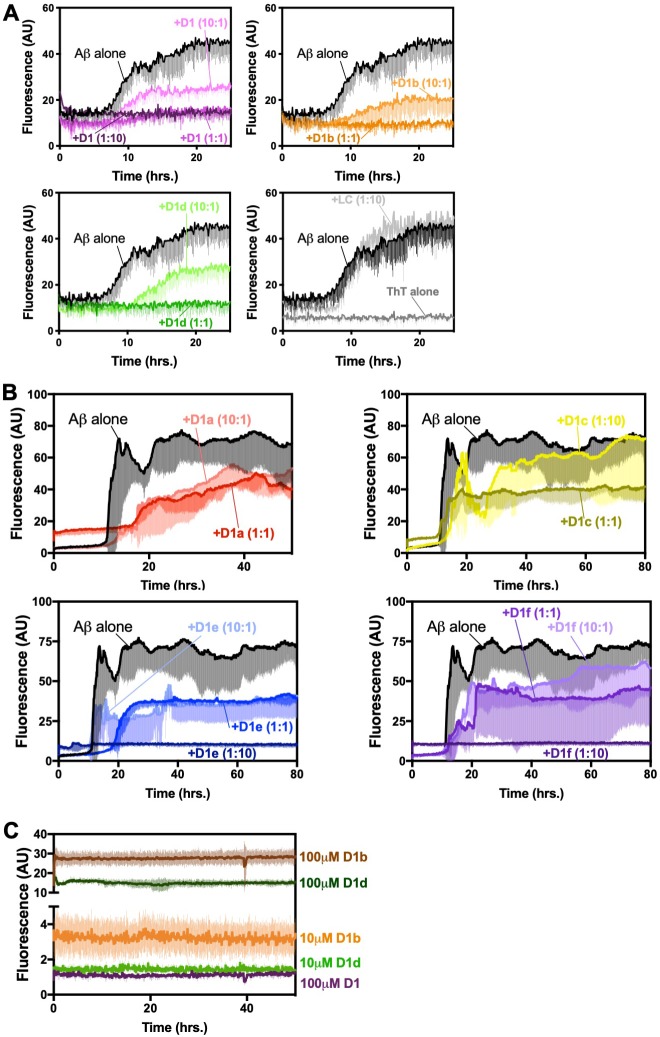
A Peptide inhibitors D1, D1b, and D1d reduce fibril formation of Aβ1–42, while negative control peptide LC does not.10 μM of Aβ1–42 was incubated alone or at a 1:10, 1:1, or 10:1 molar ratio to each inhibitor under quiescent conditions at 37°C in polypropylene plates. Fibril formation was monitored using ThT fluorescence. Curves show the average of three technical replicates with one standard deviation below. (B) Peptide inhibitors D1a, D1c, D1e, and D1f are less effective ate reducing fibril formation of Aβ1–42, 10 μM of Aβ1–42 was incubated alone or at a 1:10, 1:1, or 10:1 molar ratio to each inhibitor under quiescent conditions at 37°C. Fibril formation was monitored using ThT fluorescence. Lines show the average of three technical replicates with one standard deviation below. Inhibitors D1a and D1c are not shown at (1:10) ratio due to high ThT signal from peptide self-association. (C) Peptide inhibitors D1b and D1d self-associate at high concentrations. Peptide inhibitors were incubated at 10 μM and 100 μM under quiescent conditions at 37°C. Fibril formation was monitored using ThT fluorescence. Lines show the average of three technical replicates with one standard deviation displayed below.